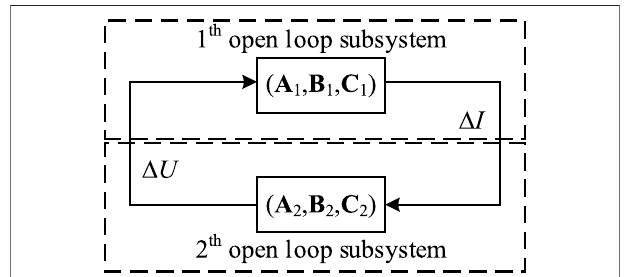
FIGURE 1 | Closed-loop interconnection model.